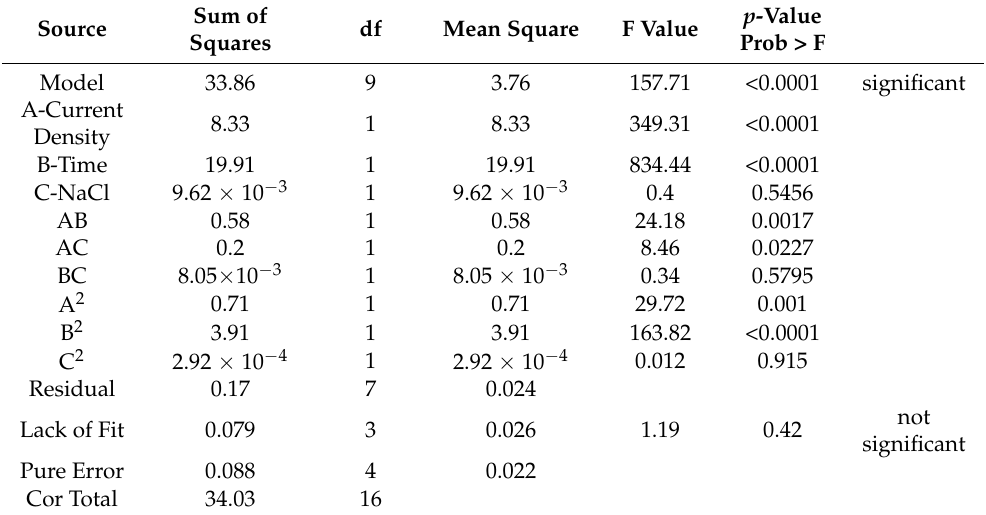
Table 3. ANOVA analysis (Y 1 ).